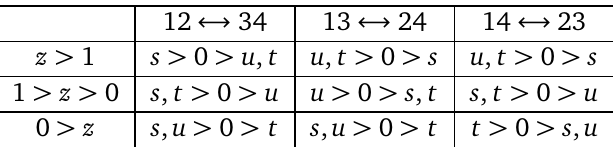
Table 3: The physical and “unphysical" kinematic